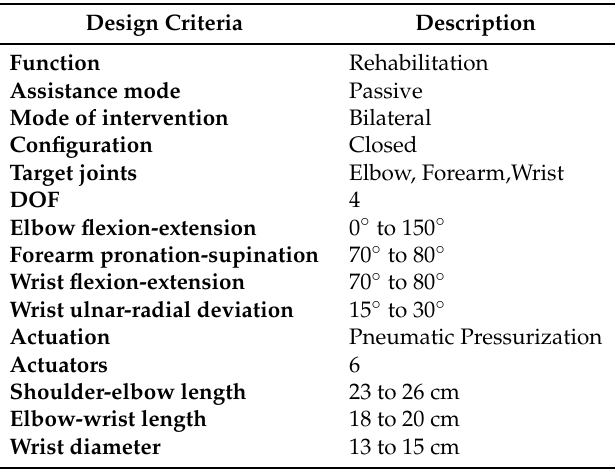
Table 4. MOSAR’s customized